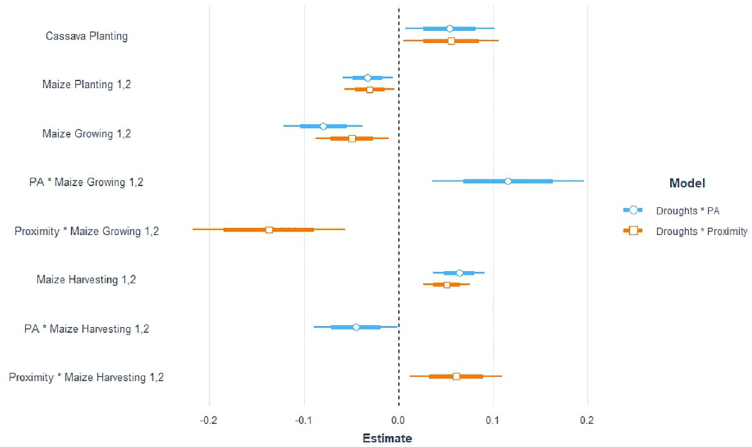
Fig 4. Deforestation and current droughts; graphical representation of interaction with protected areas and proximity to main cities.